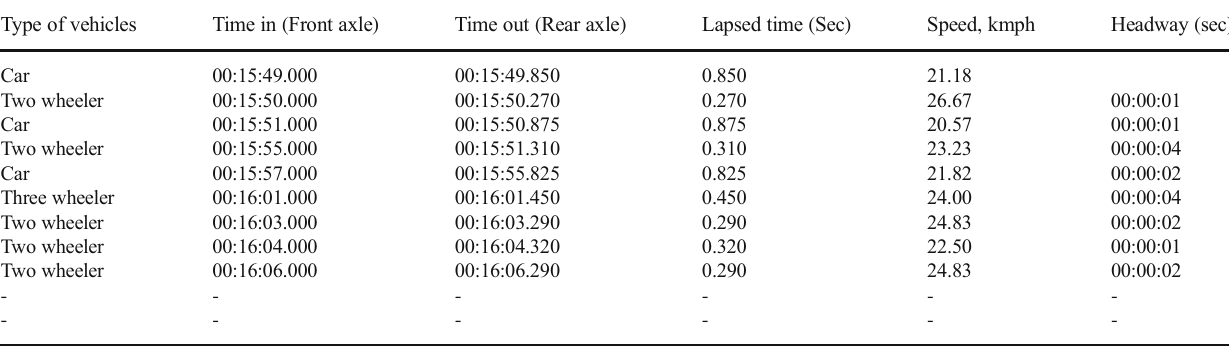
Sample data collected on the selected highway section Type of